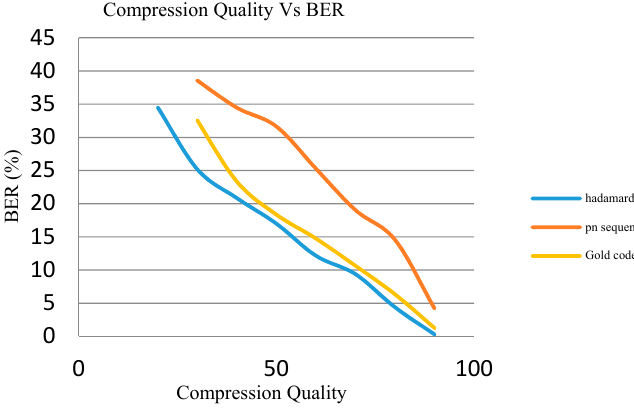
Figure 11. Compression Quality Vs BER in the case of different types of spreading codes.